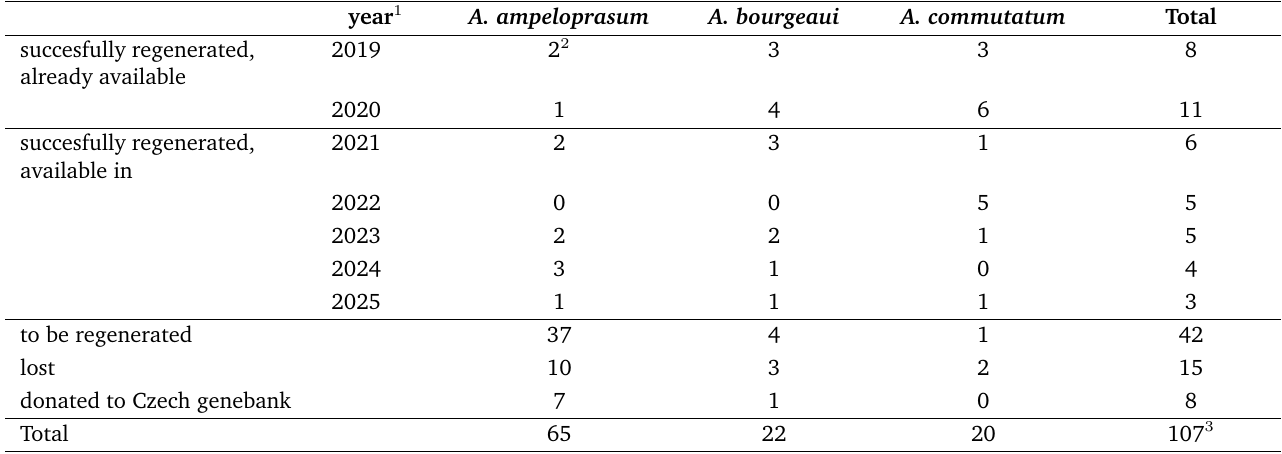
Table 2. Overview of the regeneration process of leek CWR. 1) year when material will be publicly available; 2) number of populations; 3) 107 = 104 (populations) + 3 (mixed species populations that were subdivided during the regeneration process, based on their species identity and thus resulting in three extra populations for